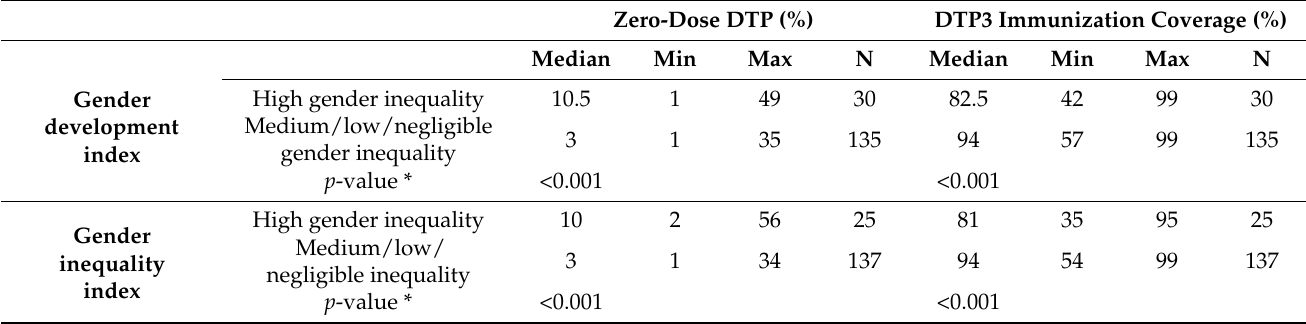
Table 2. Prevalence of zero-dose DTP and DTP3 immunization coverage by gender inequality, 2019.